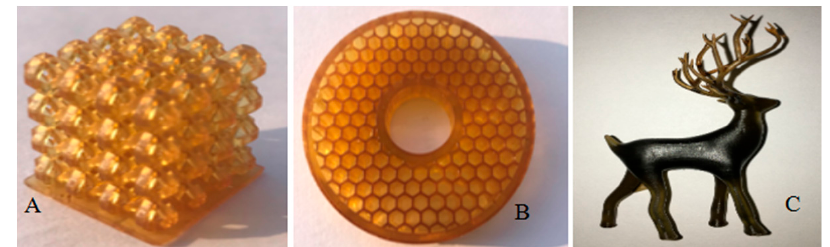
Figure 9. 3D printing of hybrid resin. ( a ) hollow structure, ( b ) honeycomb structure, ( c ) elk.